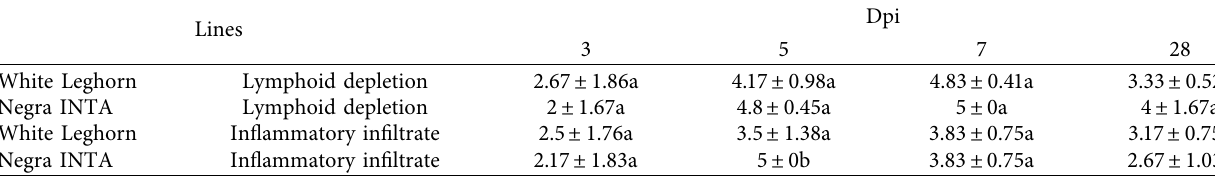
Table 1: Histopathological bursal lesions of infected chickens.